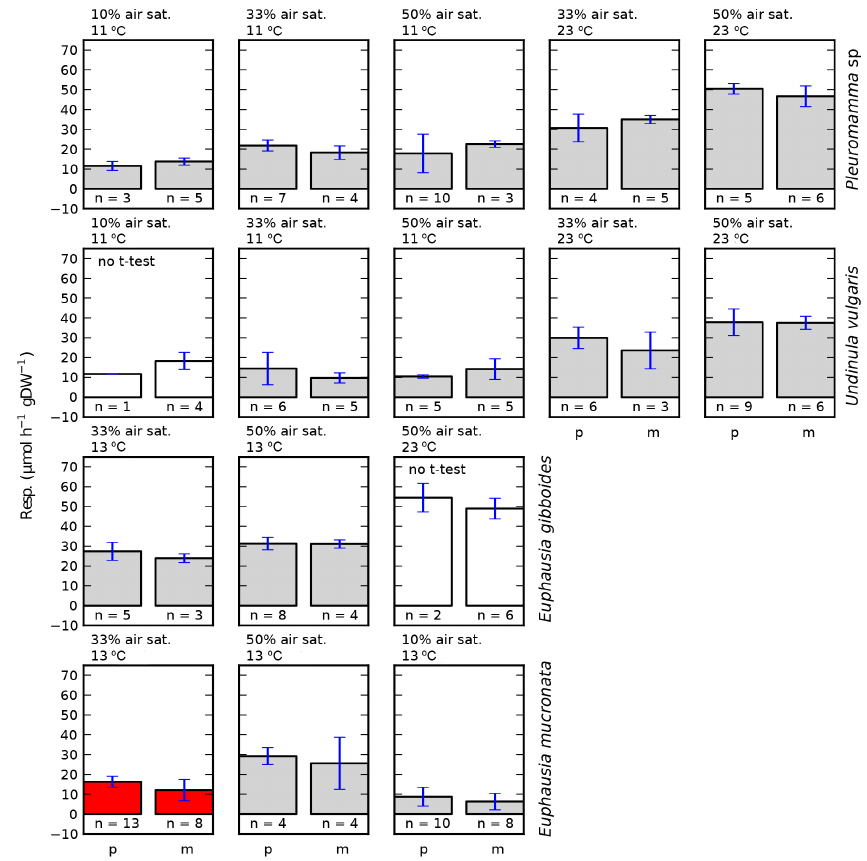
Figure 3. Weight-specific respiration rates of calanoid copepods and euphausiids at different temperatures, air saturation and CO 2 -levels. p = CO 2 -plus, m = CO 2 -minus. Red barplot colour indicates a statistically significant difference ( t test, p< 0 . 05) between CO 2 -plus and CO 2 -minus treatments. Each row contains data for only one species, with low temperatures on the left side of the row and high temperatures on the right side and air saturation increasing from left to